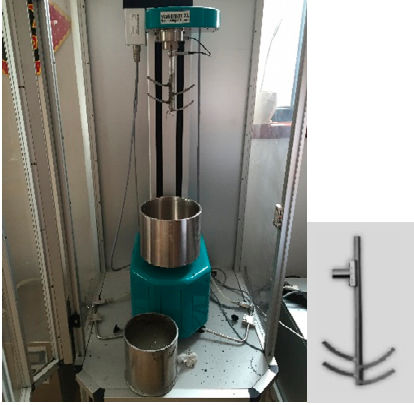
Figure 1. Viskomat XL mortar rheometer.